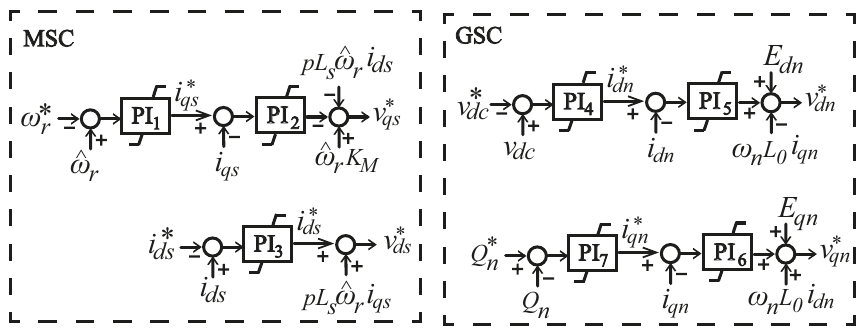
Figure 2. PI control scheme for comparison with the proposed finite-time controller (FTC).